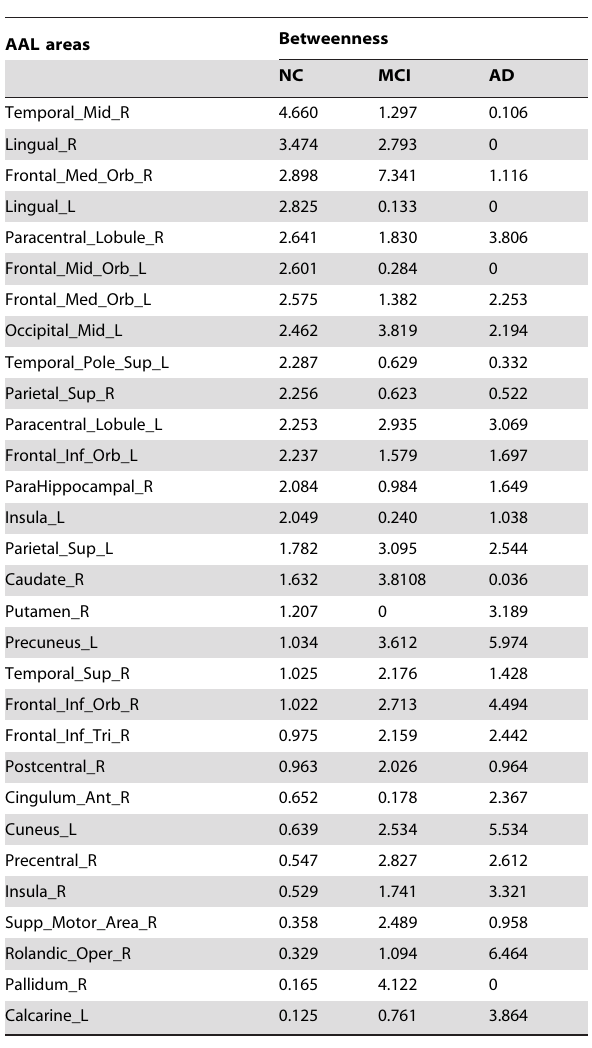
Table 1. Hub regions in cortical networks of the three populations listed in descending order of their normalized betweenness in the